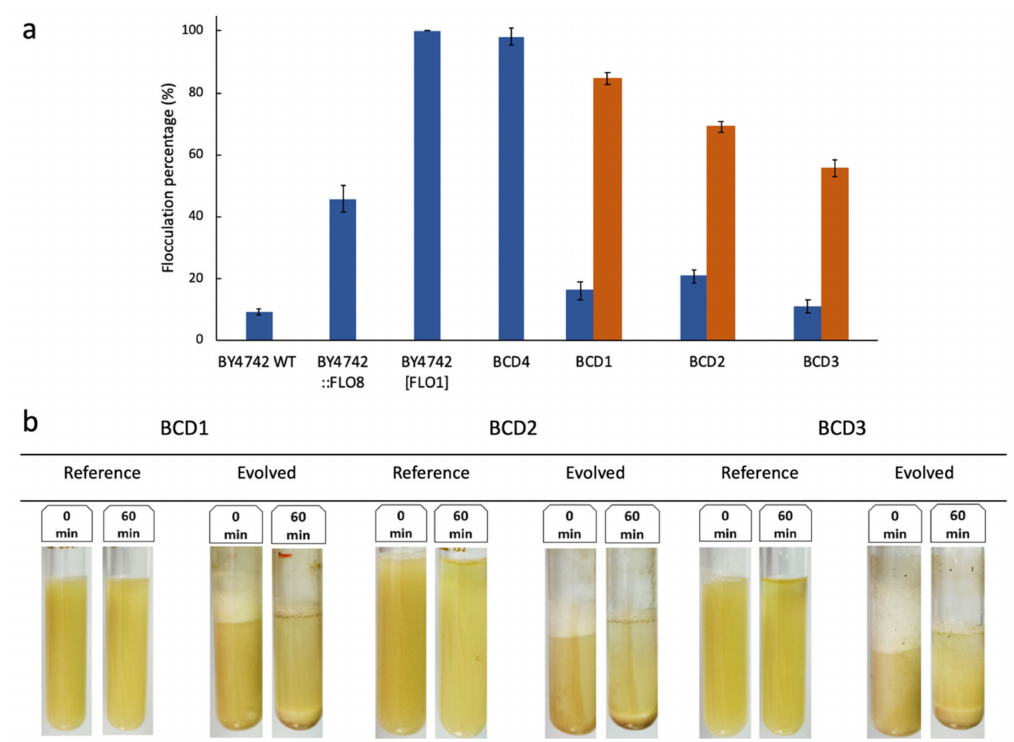
Figure 1. Flocculation and sedimentation behavior of laboratory and industrial strains. ( a ) Flocculation percentages determined for the control strains (BY4742, BY4742:: FLO8 , BY4742 ( FLO1 ), the industrial BCD4 strain) and for the three industrial non-flocculating strains BCD1, BCD2, and BCD3 before ( (cid:4) ) and after ( (cid:4) ) ALE in ministats. All measurements were performed in triplicates. ( b ) The sedimentation behavior of the three industrial brewer’s strains before and after adaptive laboratory evolution (ALE) in the ministats.